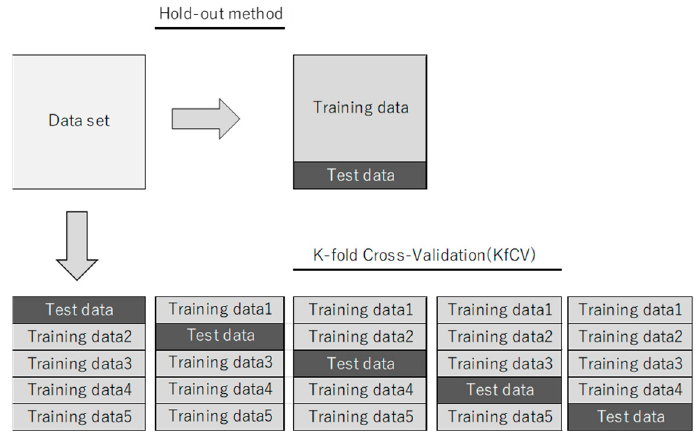
Figure 3. Evaluation methods for deep learning.